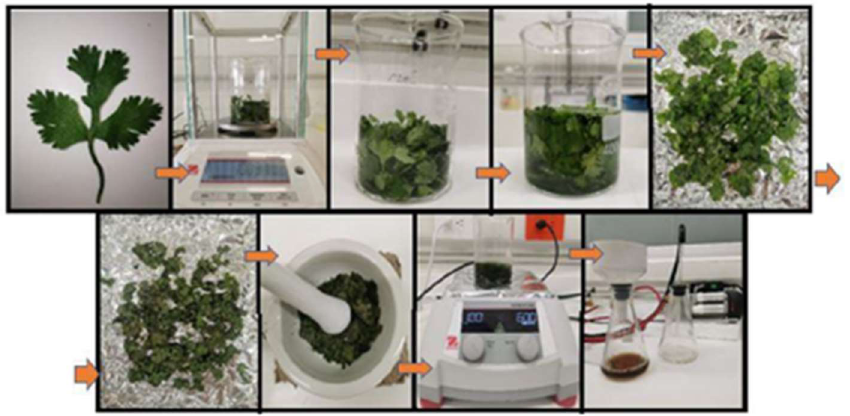
Figure 1. Coriander leaf extract preparation process.